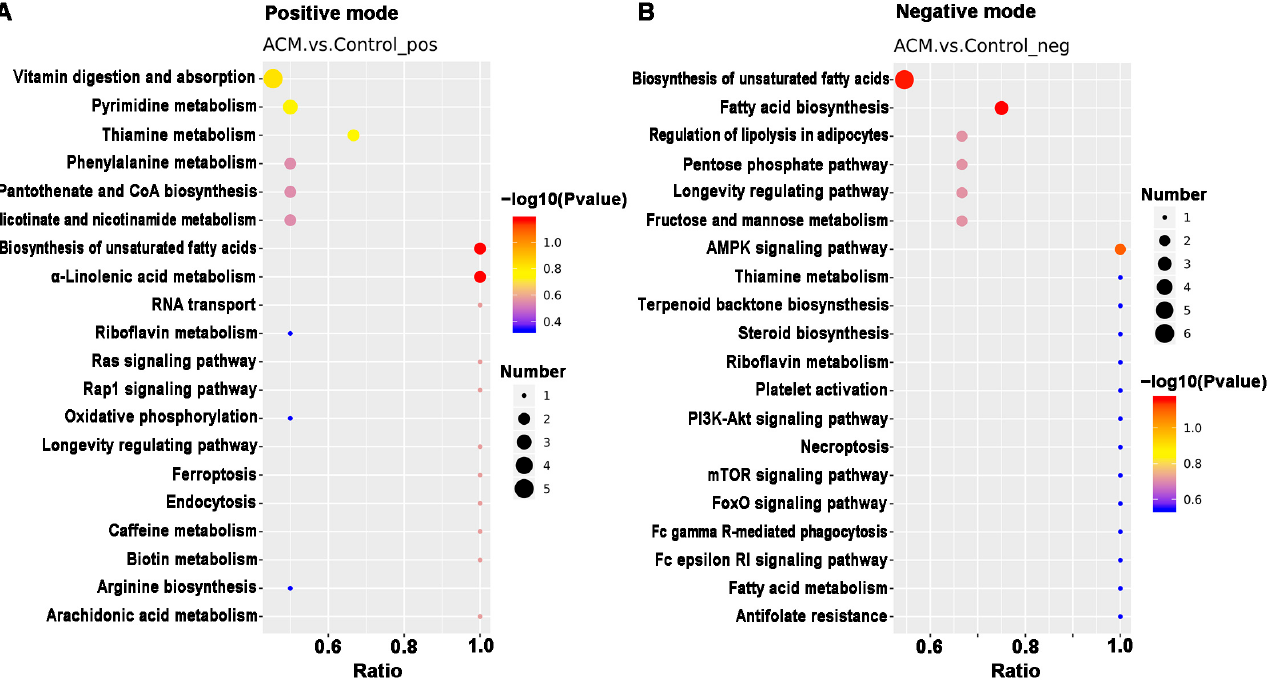
Figure 6. Heatmaps of differentially expressed metabolites between the control and ACM groups. ( A ) Positive mode; ( B ) negative mode.